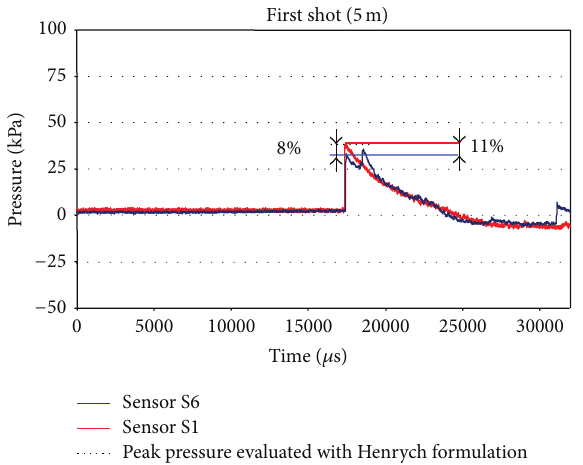
Figure 7: Acquired pressure histories: first blast.